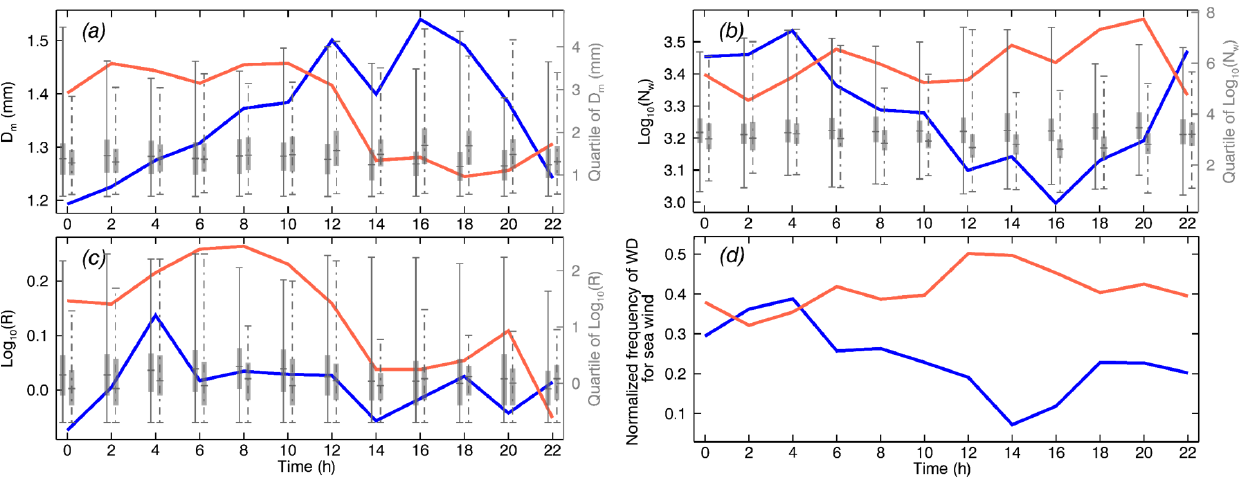
Figure 11. Two-hour interval time series and quartiles of (a) D m , (b) log 10 ,(N w ) (c) log 10 (R) , and (d) normalized frequency of wind direction for sea wind (45 to 225 ◦ ) for the summer (red) and winter (blue) seasons. Solid (broken) lines are quartiles of summer (winter) for each time, respectively.